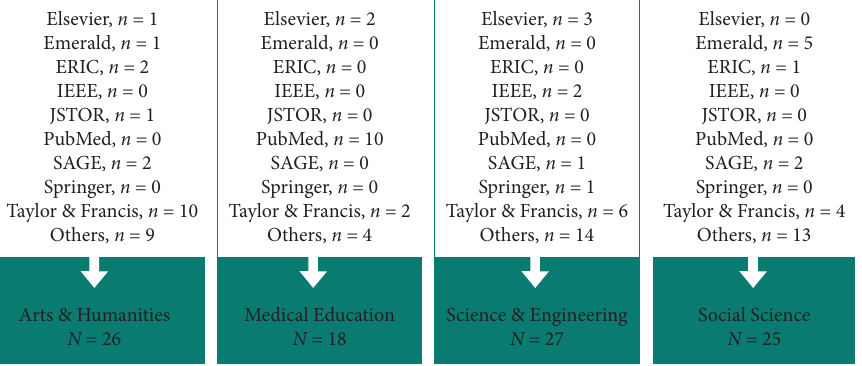
Figure 2: Number of articles studied for each